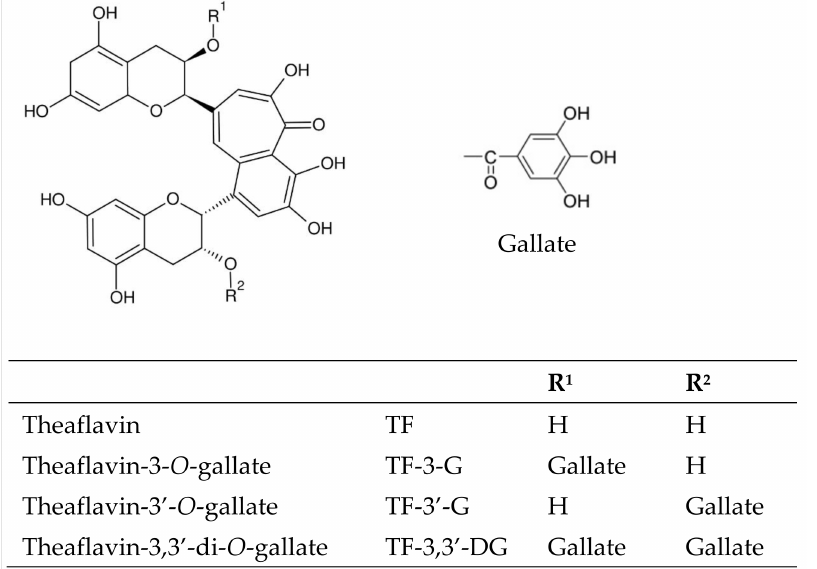
Figure 1. Chemical structures of theaflavins (TF, TF-3-G, TF-3 (cid:48) -G, and TF-3,3 (cid:48) -DG) found in black